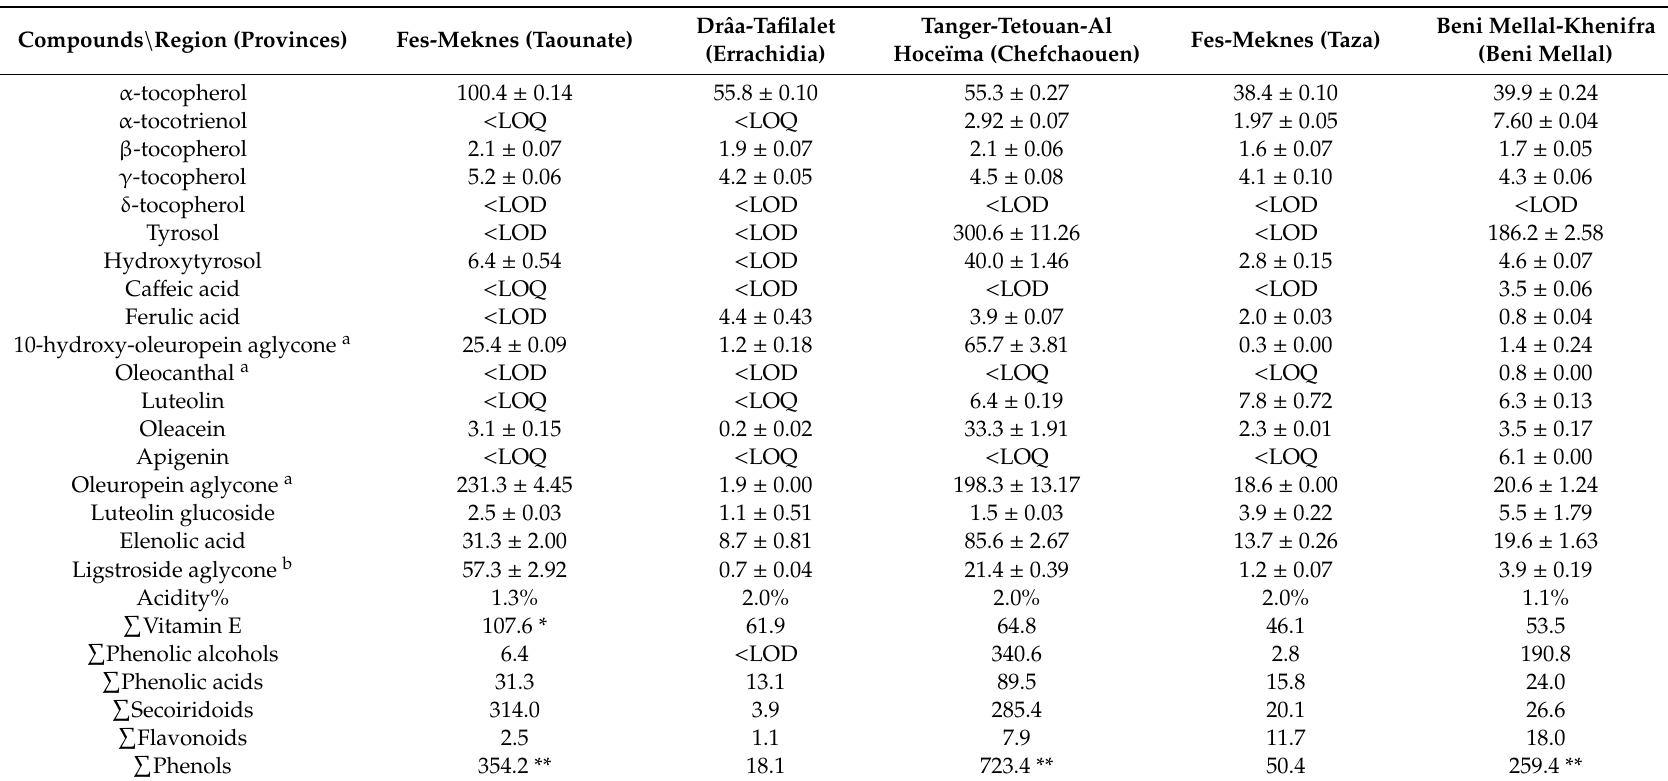
Table 1. Quantitative values as average (mean ± SD) determination of bioactive molecules in virgin olive oils (VOOs) of Picholine marocaine from five provinces studied. Results are expressed as mg.kg − 1